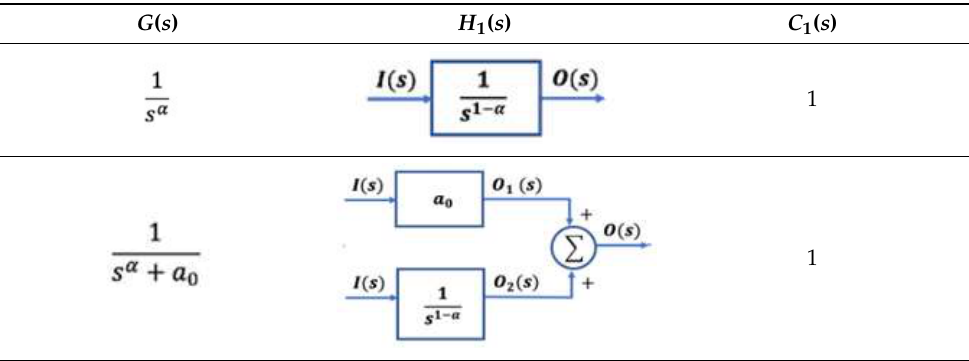
Table 2. Realization of the Inner Loop Compensation Terms.